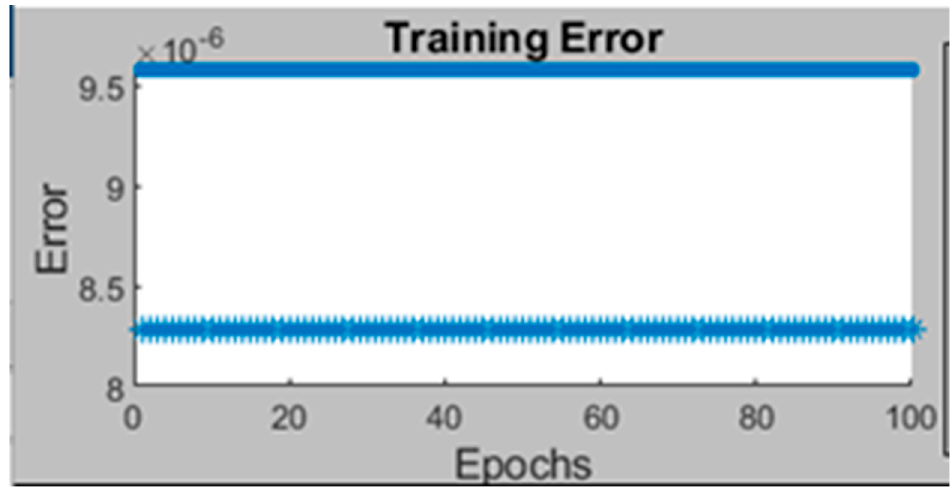
Figure 18. RMSE plot for grid partitioning.